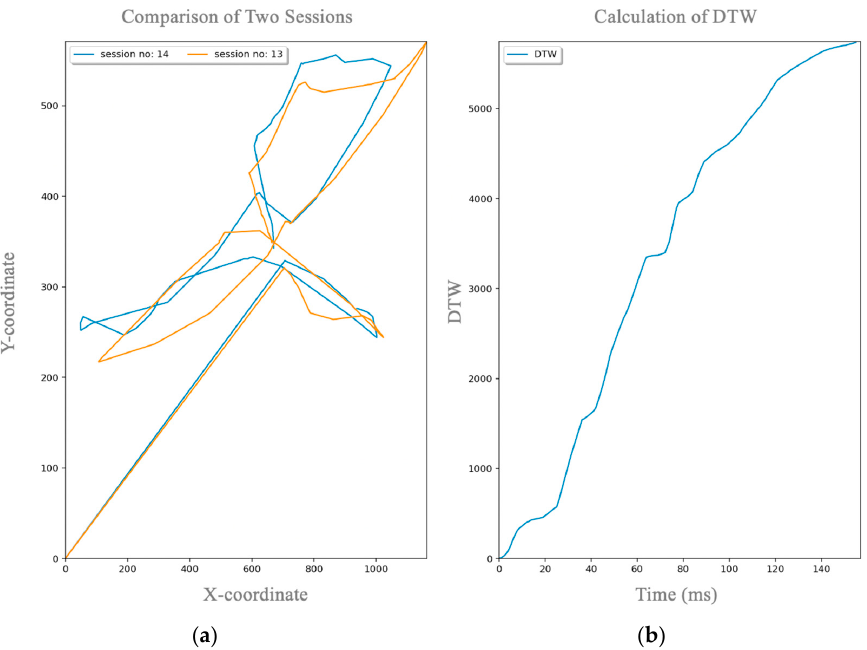
Figure 6. Cumulative difference/distance between subsequent pairs of sessions generated by user 82.